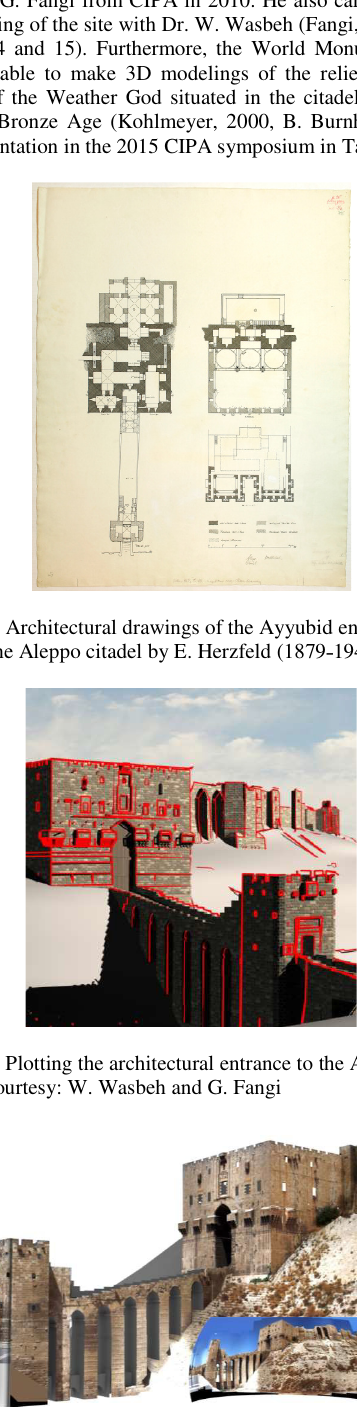
Figure 15. The 3D modeled entrance to the Aleppo citadel. Courtesy: W. Wasbeh and G.